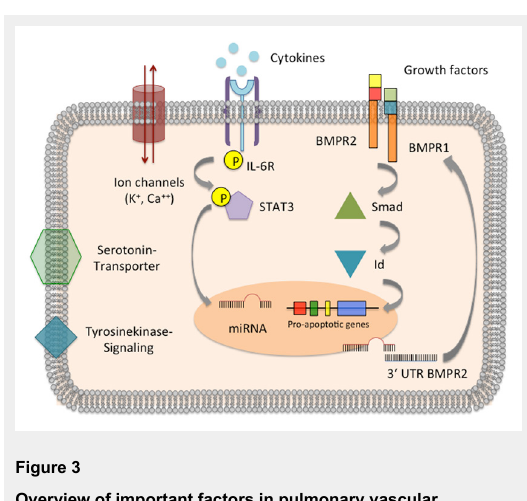
Overview of important factors in pulmonary vascular remodelling . BMPR2 is expressed on pulmonary artery smooth muscle cells and is the master regulator in remodelling of pulmonary arteries. Upon binding of ligands, BMPR2 and BMPR1 dimerise and activate proapoptotic genes through the action of the transcription factors Smad and Id (inhibitor of differentiation). Dysregulation of this pathway, for example due to mutations in BMPR2 , results in a proproliferative state. Inflammatory cytokines (e.g. interleukin-6 [IL-6]) phosphorylate the transcription factor STAT3 and induce the expression of miRNAs. MicroRNAs act as gene silencers and downregulate BMPR2, which directly inhibits cell cycle regulators. Ion channels, serotonin transporters and receptors associated with tyrosine kinase signalling are also involved in mediating vasoconstriction and